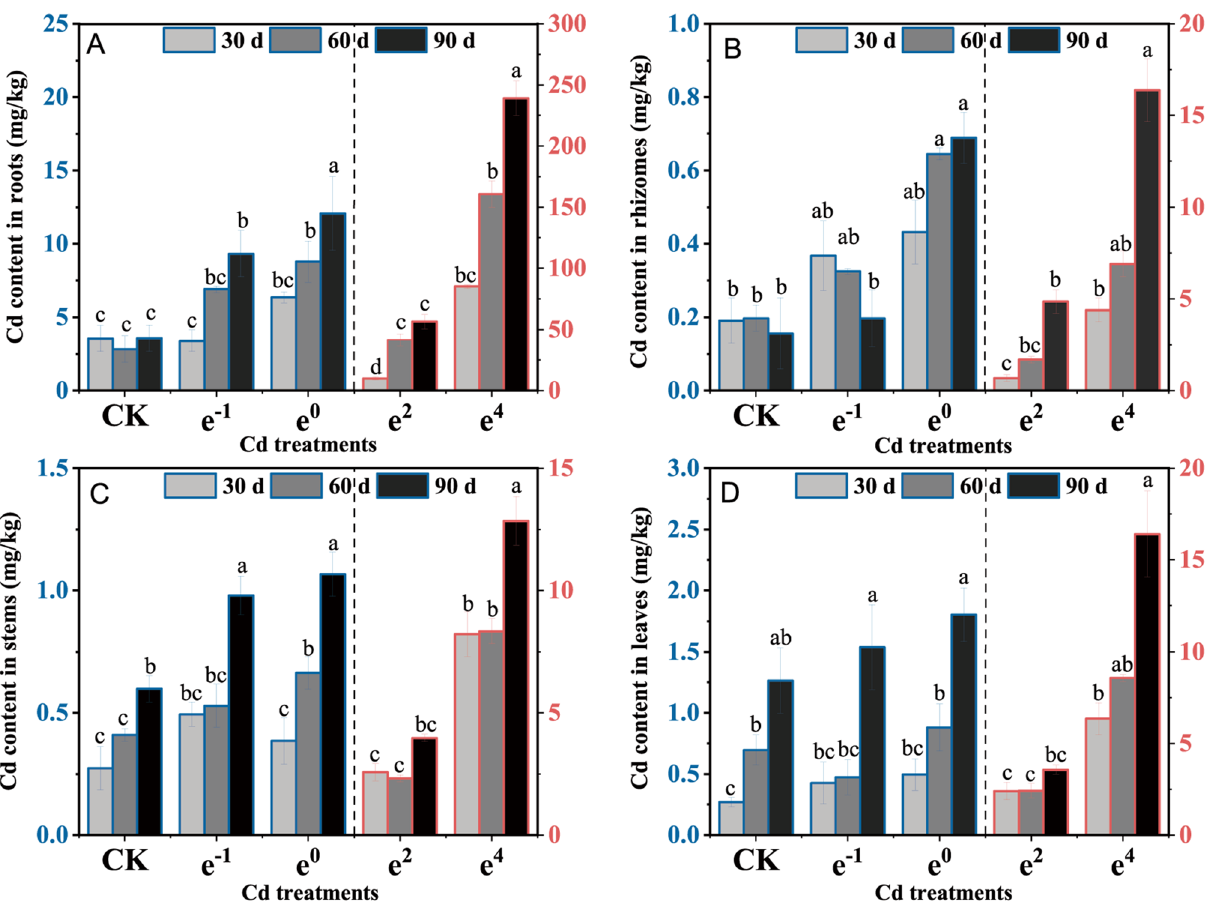
Figure 2. Cd content in the roots, rhizomes, stems, and leaves of Polygonatum sibiricum . ( A ) Root Cd content; ( B ) rhizome Cd content; ( C ) stem Cd content; ( D ) leaf Cd content. Each value represents the mean ± standard deviation of three independent experiments. Different letters above the bars represent significant differences ( p <